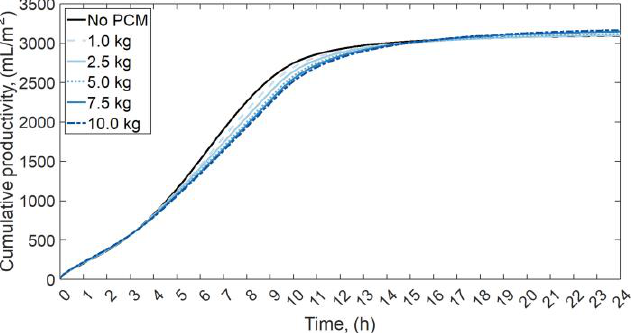
Figure 16. The cumulative productivity of the SS with different masses of PCM — Case 2. Table 8. The productivity of the SS with and without PCM for different cases. Percentage Improvement (+) Case Mass of PCM, (kg) Productivity, (mL/m 2 /day)